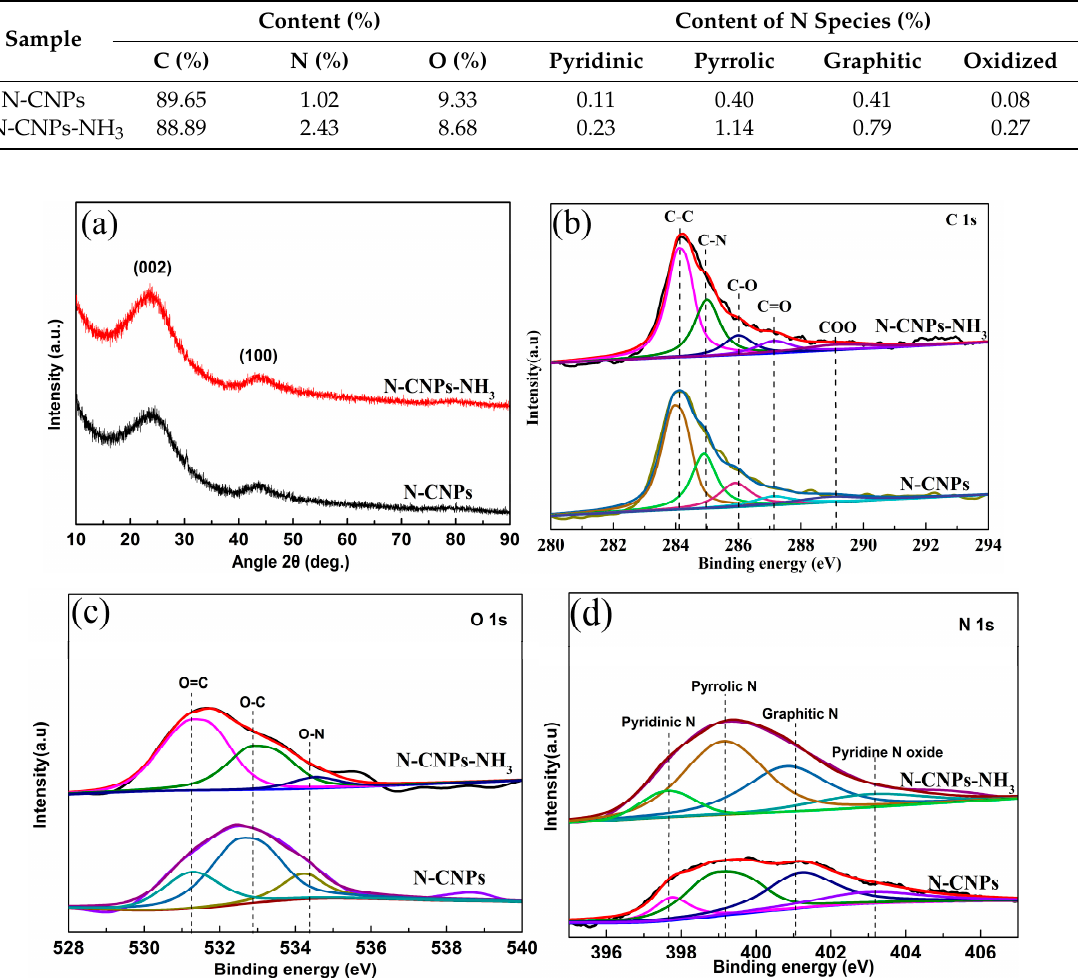
Table 2. Atomic content of N-CNPs and N-CNPs-NH 3 .